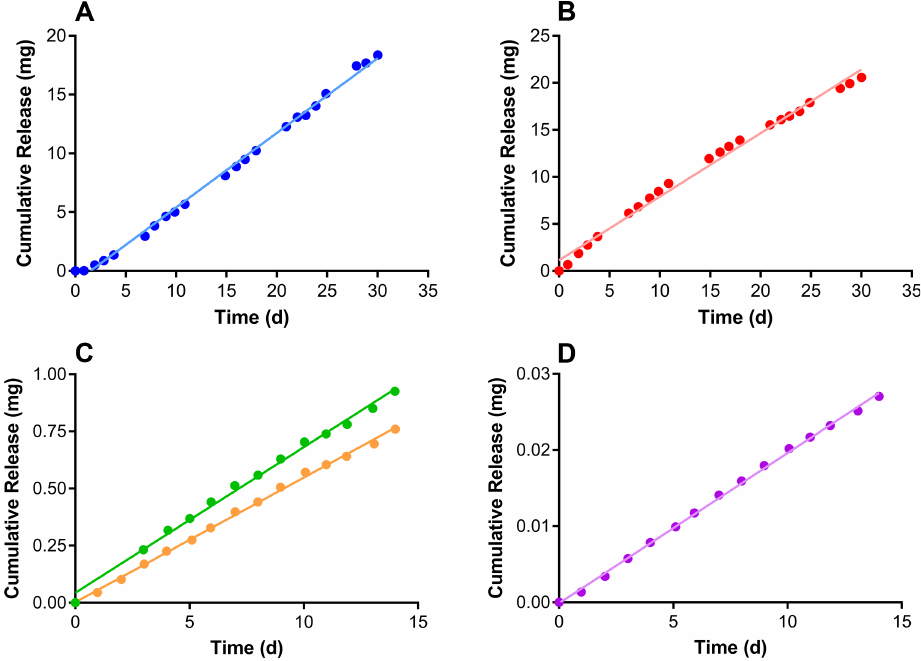
Fig 2. TAF 2 -ACV-ENG-EE pod-IVR in vitro release kinetics. Circles correspond to means (N = 4–6) and lines correspondto linear regressions. (A) TAF 2 . (B) ACV. (C) ENG: green, pod-IVR Configuration A; orange, pod-IVR Configuration B. (D)